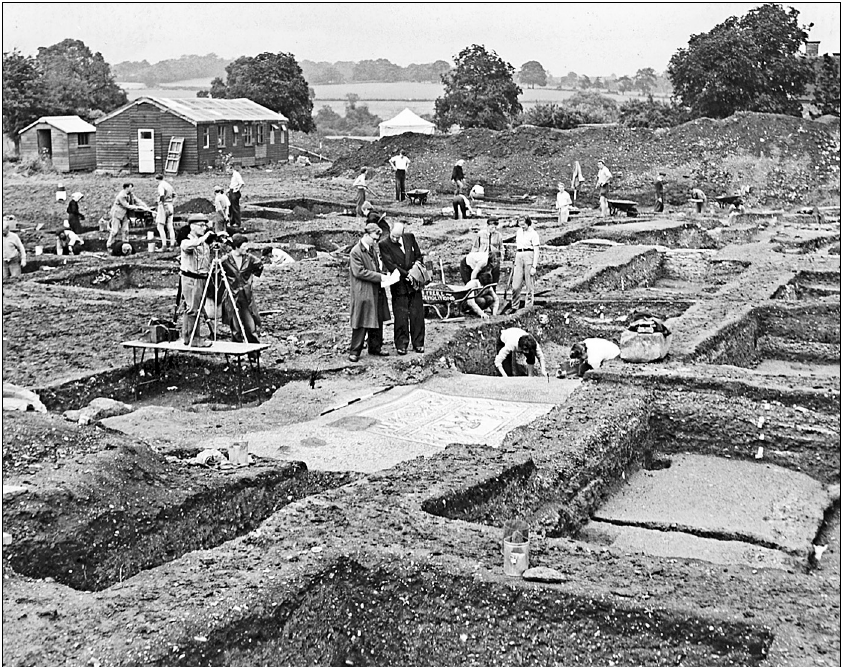
Figure 2 Excavation in progress at Verulamium in 1958, with Maurice Cookson (left) photographing a mosaic